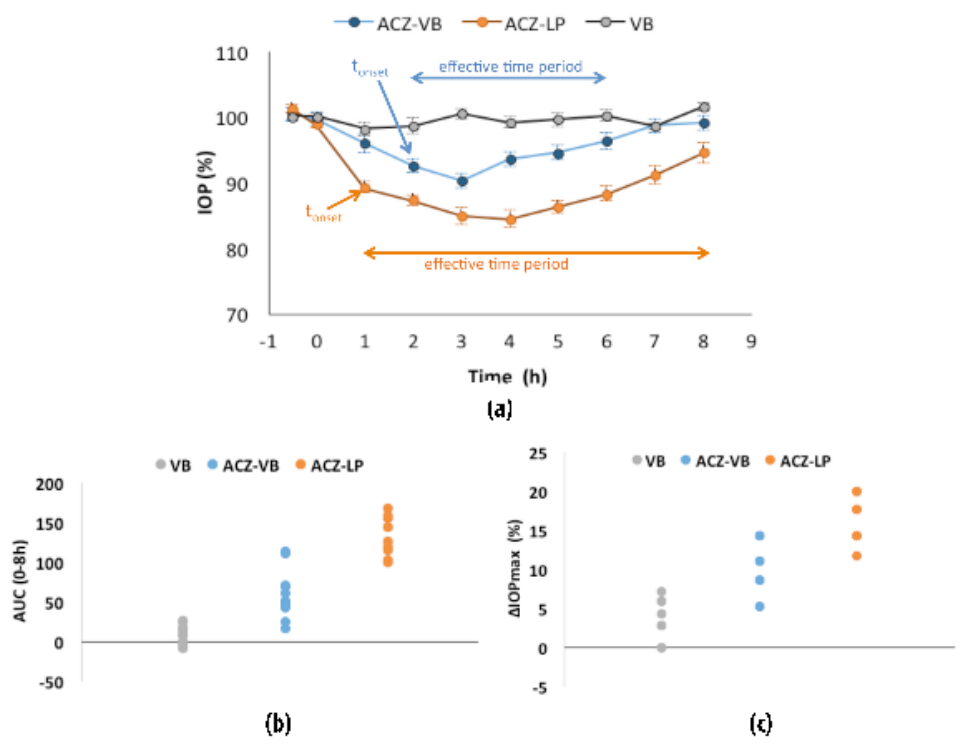
Figure 2. Stage one: ( a ) Intraocular pressure (IOP, %) mean after instillation of 25 µ L of ACZ-VB (0.7 µ g / mL acetazolamide in vehicle base), ACZ-LP liposomal formulation (0.7 mg / mL acetazolamide and 20 mg / mL liposomes expressed in concentration of PC in vehicle base) and VB (vehicle base used as control). ( b ) Area under curve of the ∆ IOP (%) versus time (h) from 0 to 8 h—AUC (0–8h) . ( c ) Maximal IOP reduction ( ∆ IOP max , %). The results are expressed as the mean ± standard error. Table 3. Probability values obtained for the different sources of variation of the statistical model proposed.